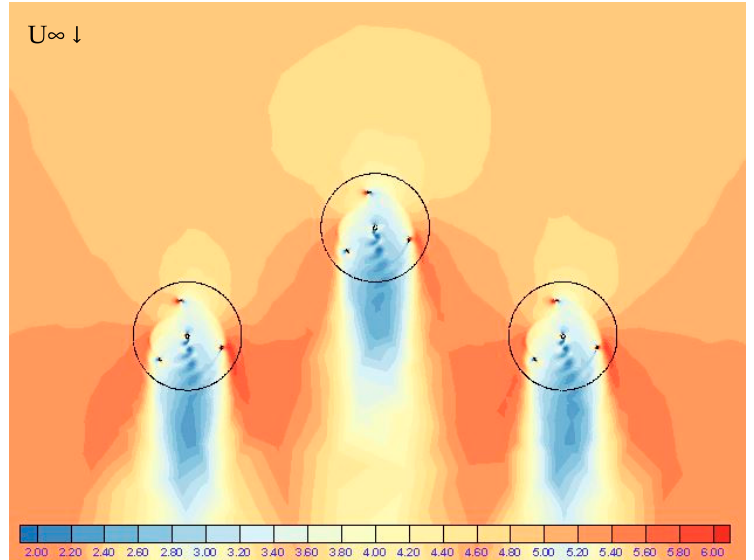
Figure 13. Velocity contours near the left, right and center turbine.